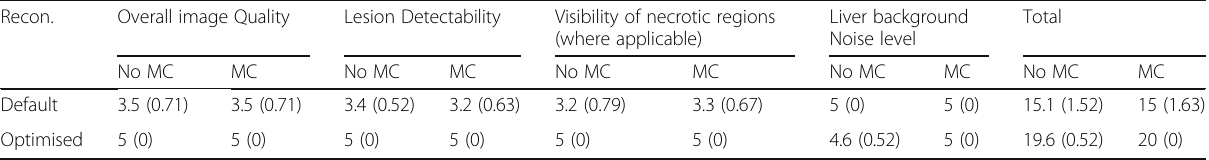
Table 2 Results from clinical evaluation of patient images. Numbers are mean averages over all 10 patients and numbers in brackets indicate the standard deviation